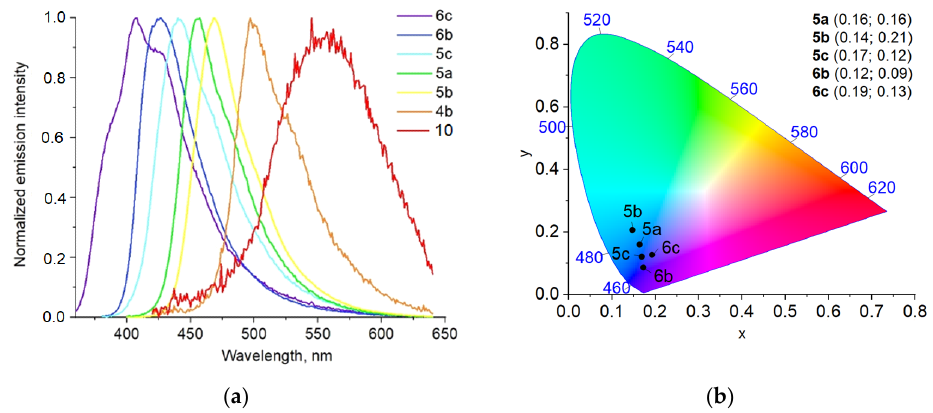
Figure 7. ( a ) Normalized emission spectra of quinazolinones 4 – 6, 10 in solid state; ( b ) The CIE chromaticity diagram of blue chromophores 5a–c , 6b,c in solid state. In terms of the chemical structure, the observed differences in solid-state emission ents arrangement (para or meta). Diphenylamino-derivatives 4b , 5b and 6b demonstrate